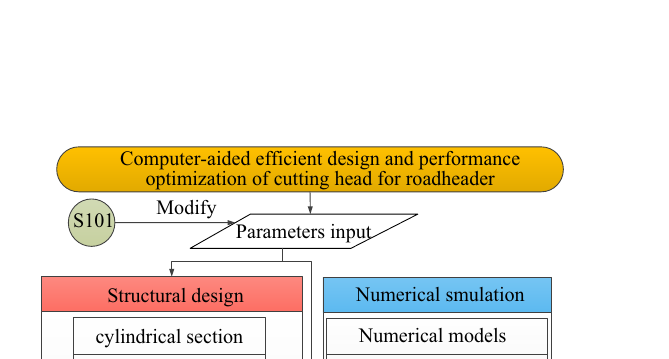
Figure 15. Relationship surfaces of each cutting performance index with the cross-swing speeds and rotation speeds: ( a ) cutting load; ( b ) cutting specific energy consumption; ( c ) maximum cutting area; ( d ) cutting power.